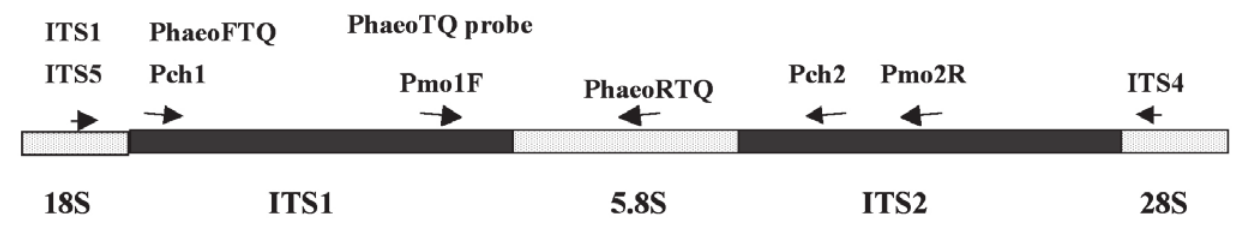
Fig. 1. The location of each of the PCR primers and the PhaeoTQ TaqMan ® probe along the ribosomal DNA region of P.